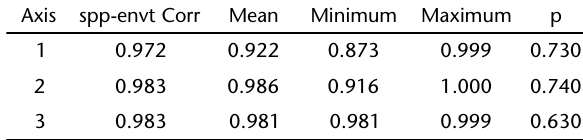
Table III. Self-values (eingenvalue) of the Canonical Corres- pondence Analysis (CCA) of the matrix of environmental characteristics in respect to species distribution, and significance level obtained through the Monte Carlo test.